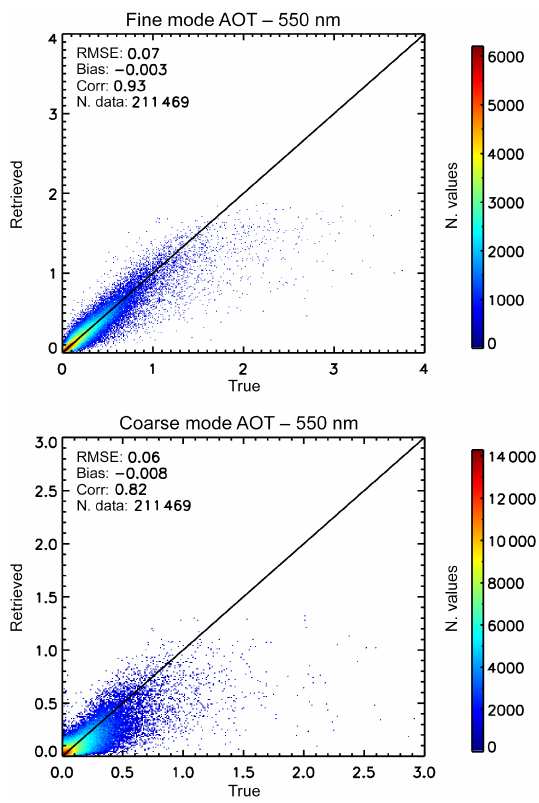
Figure 4. Neural network retrieved versus true fine- and coarse- mode AOT from synthetic test